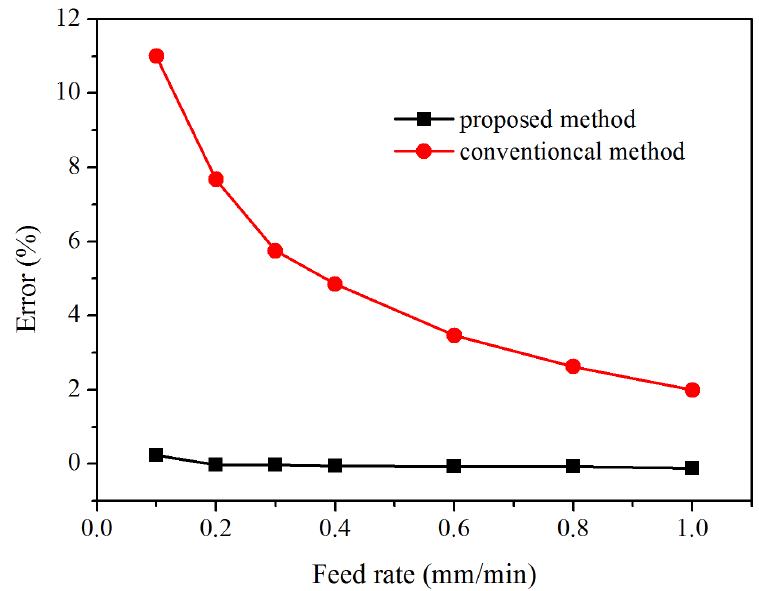
Figure 11. The error between the processing current and the ideal current.